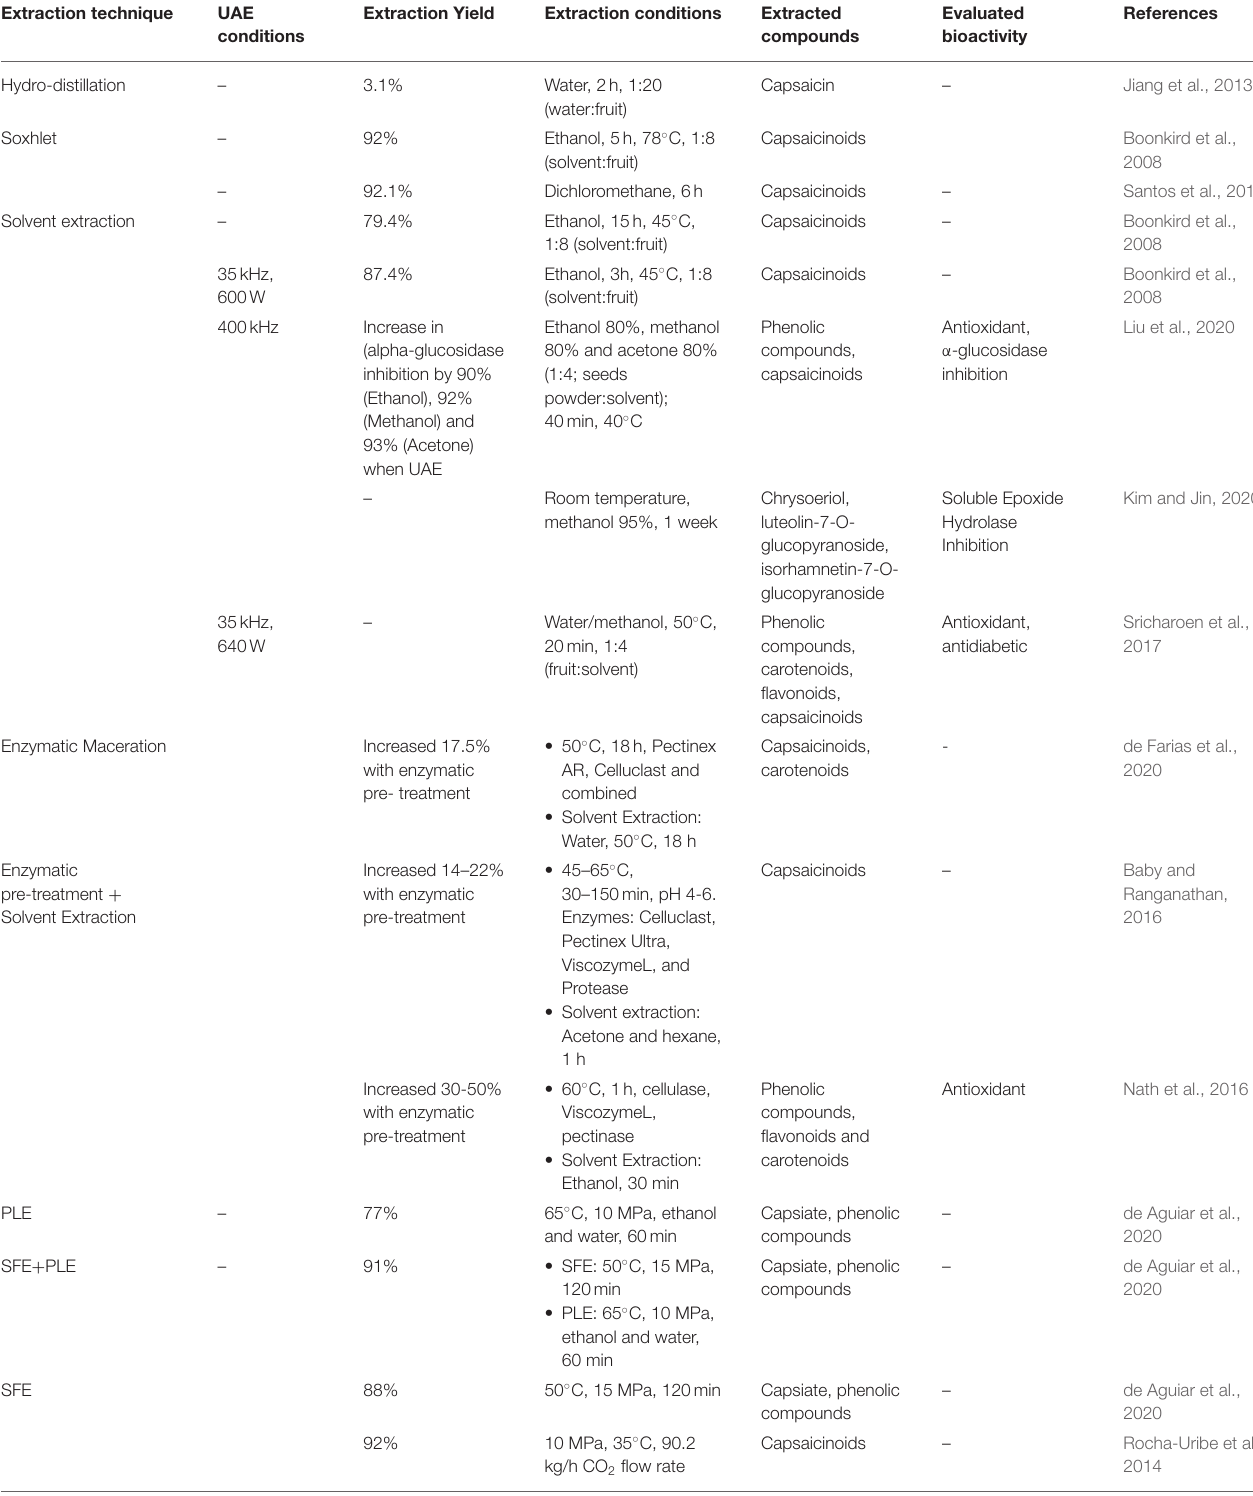
TABLE 1 | Comparison of different extraction techniques used to recover capsaicinoids and other phytochemicals with potential beneficial effects on